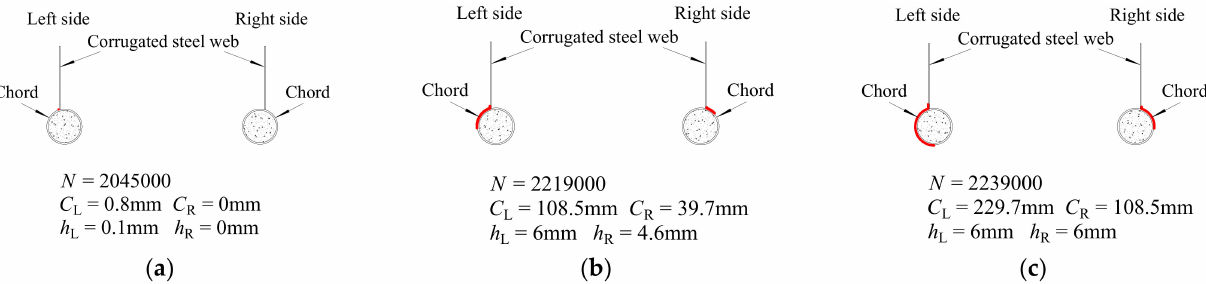
Figure 13. Fatigue crack detection results: ( a ) initiation; ( b ) propagation; and ( c ) failure. When the reversed loading cycles were between 2,045,000 and 2,145,000, the strain at XL3 and displacement at WL2 grew rapidly. The time history of strain at XL3 had a point of inflection and then exhibited a stepped decline when the reversed loading